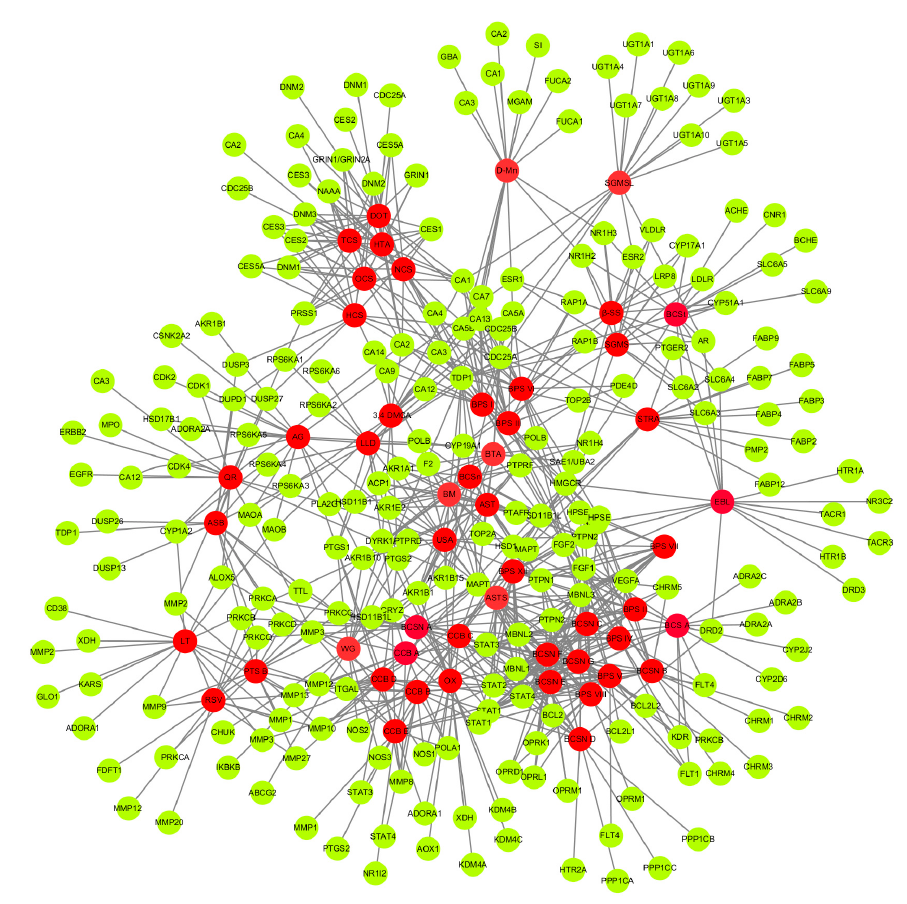
Figure 5. Compound target network (C-T-N). The red color represents compounds and the green color indicates targets.